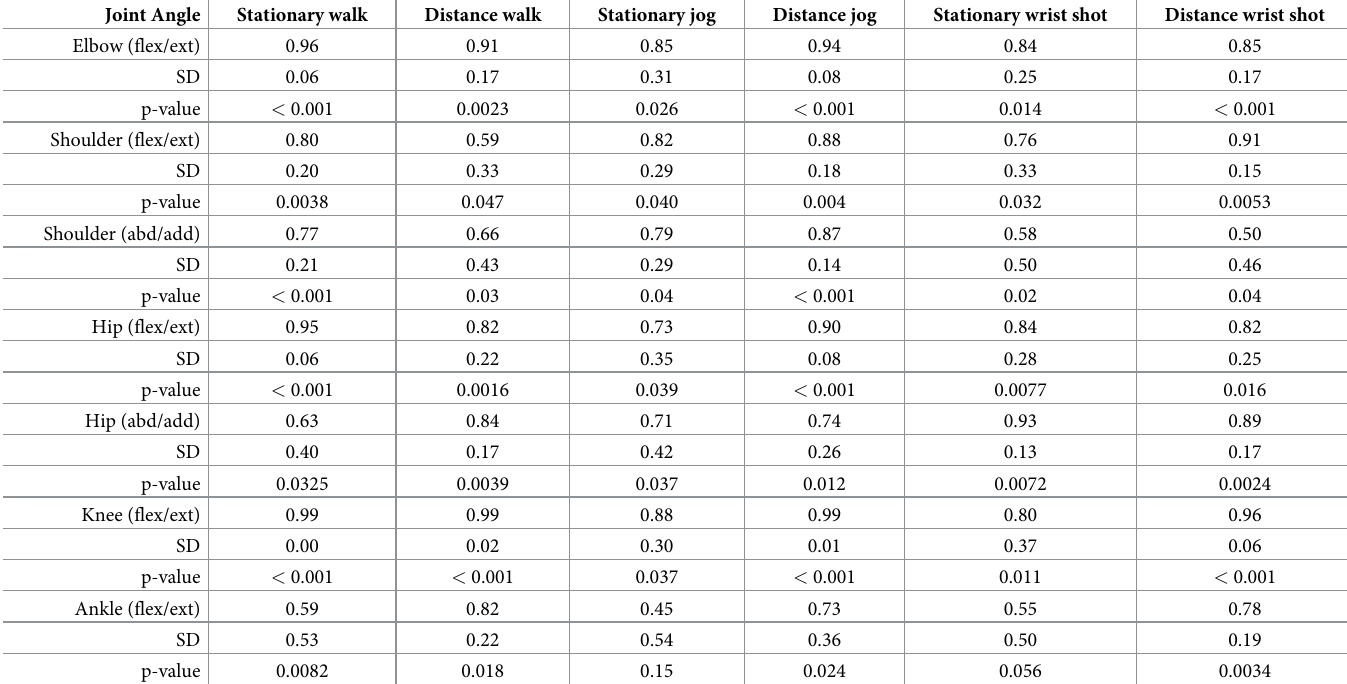
Table 3. Pearson’s correlation comparison between PNS and